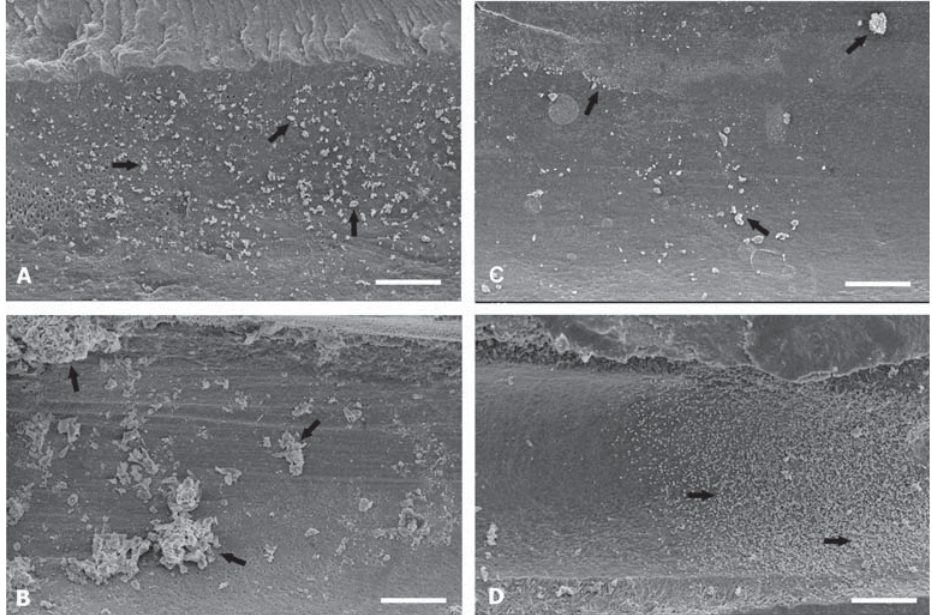
Figure 2- Scanning electron microscopy images representative of the Self-Adjusting File (A=middle third; B=apical third) and ProTaper (C=middle third; D=apical third) groups showing calcium hydroxide residues (arrows). A and C are representative of score 2: few small agglomerations of debris. B and D are representative of score 3: many agglomerations of debris covering less than 50% of the root canal wall. Scale bar=100 μm